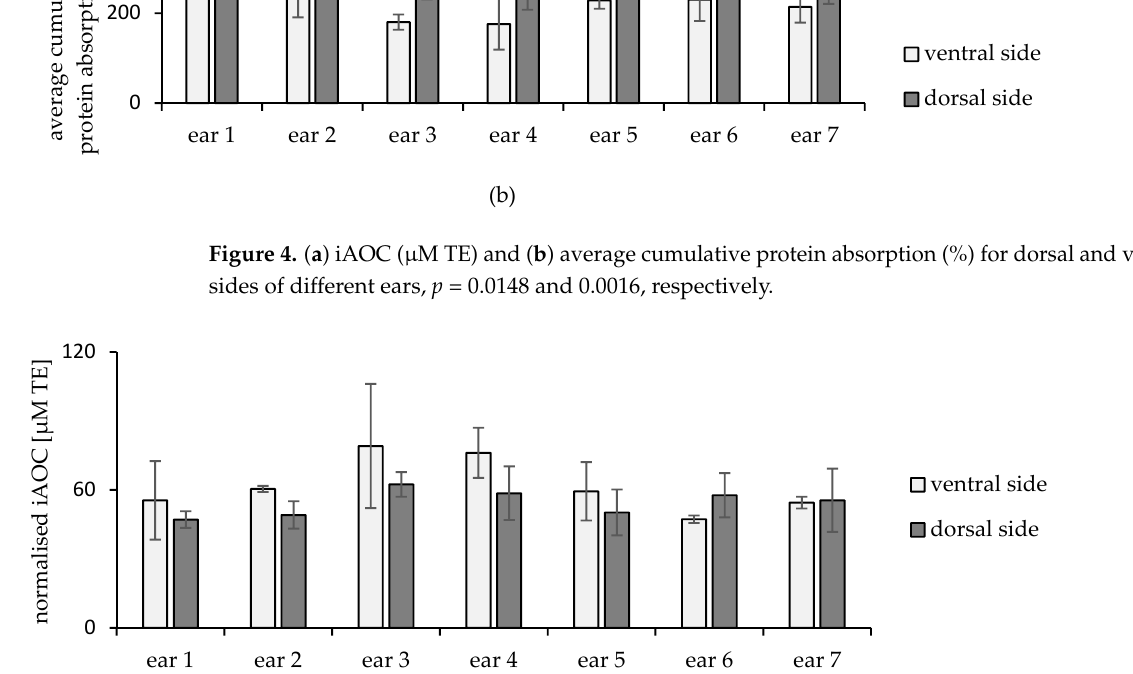
Figure 5. Normalised skin iAOC for dorsal and ventral ear sides.